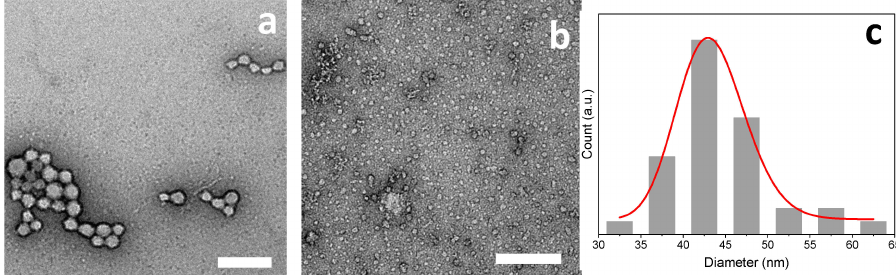
Figure 11. TEM micrographs of of chitosan-caseinate PEC nanoparticles obtained in the experiment (vi) of Case II (caseinate in excess) by adding 0.1% (w / w) solution of LMW CHI with DA = 13% to 0.1% (w / w) sodium caseinate in CHI:NaCas volume ratios of 1:10 ( a ) and 1:2 ( b ), with the corresponding dried nanoparticles size distribution ( c ) for CHI:NaCas volume ratio 1:2. Scale bars: (a; b) 200